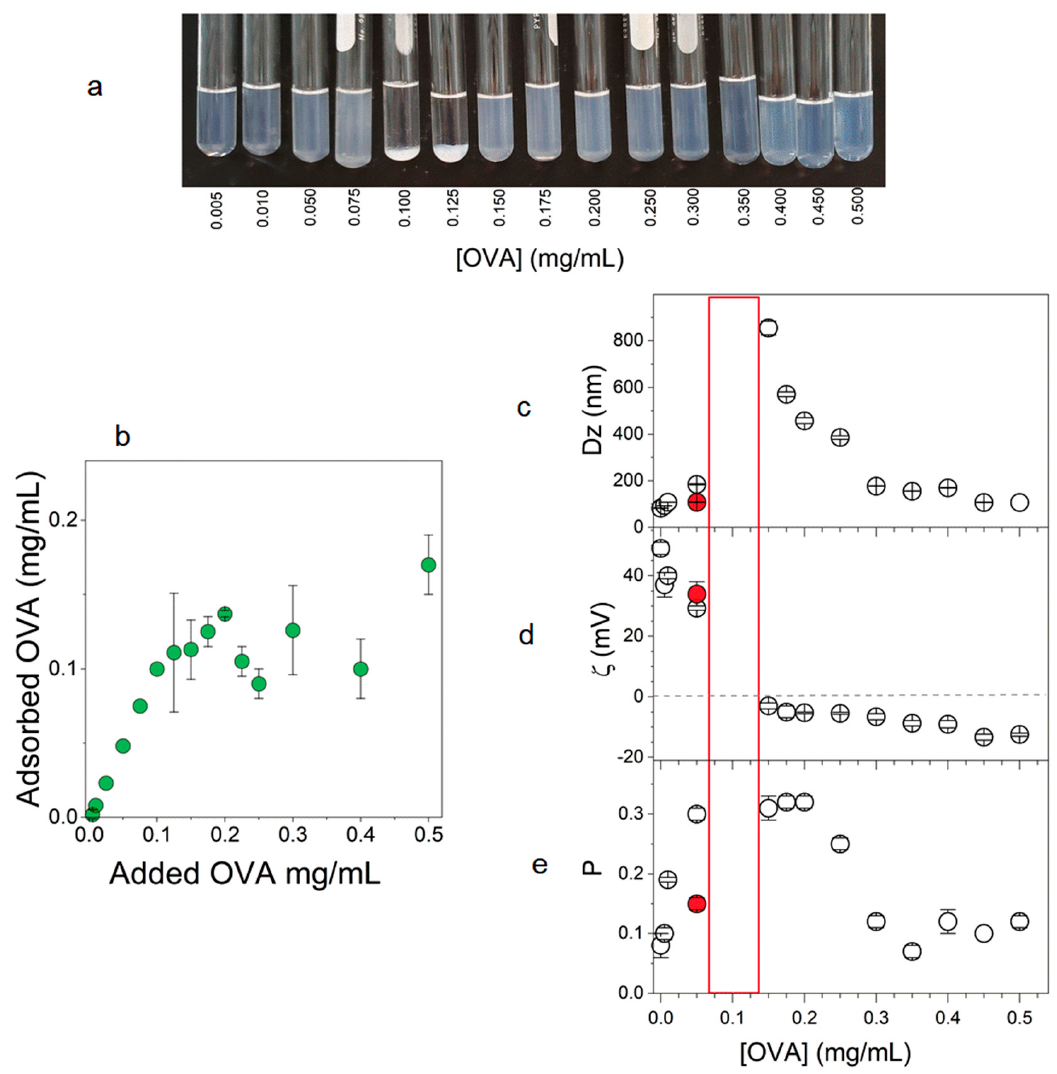
Figure 4. Poly(methyl methacrylate)/dioctadecyl dimethyl ammonium bromide (PMMA/DODAB) NPs at 0.5 mg/mL PMMA over a range of ovalbumin (OVA) concentrations: ( a ) photos of the dispersions; ( b ) OVA adsorption on NPs as a function of added OVA; ( c ) mean hydrodynamic diameter (Dz); ( d ) zeta-potential ( ζ ); ( e ) polydispersity of the dispersions (P). The stock solution of OVA used was 10 mg/mL whereas the red dot indicates properties of dispersions obtained from a 1 mg/mL OVA stock solution. The immunology tests were performed using the last stock solution of OVA. The red rectangle corresponds to the OVA concentration region of poor colloidal stability, meaning that DLS measurments could not be performed due to precipitation in the tubes.